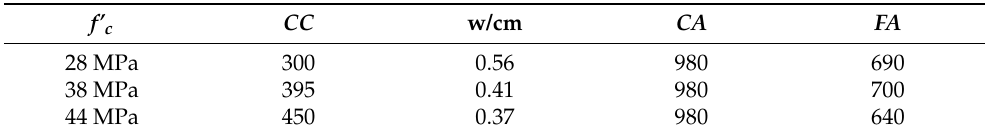
Figure 3. Gradation of aggregates. Table 2. Concrete mixtures 1